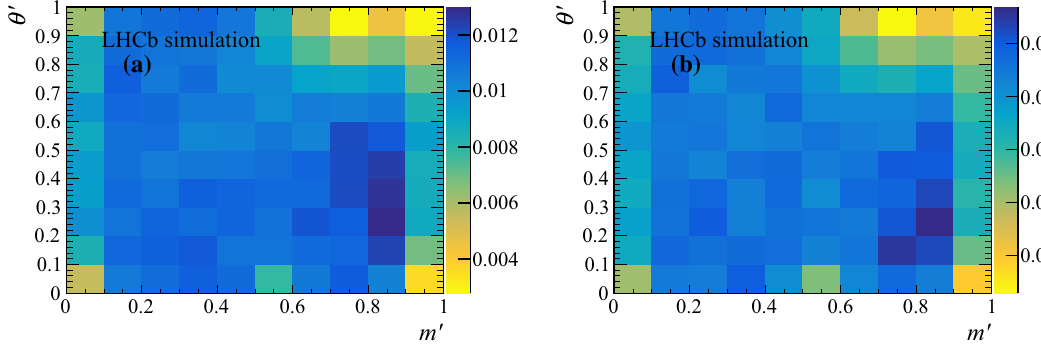
Fig. 7 B 0 → η c K + π − signal efficiency across the SDP for the a Run 1 and b Run 2